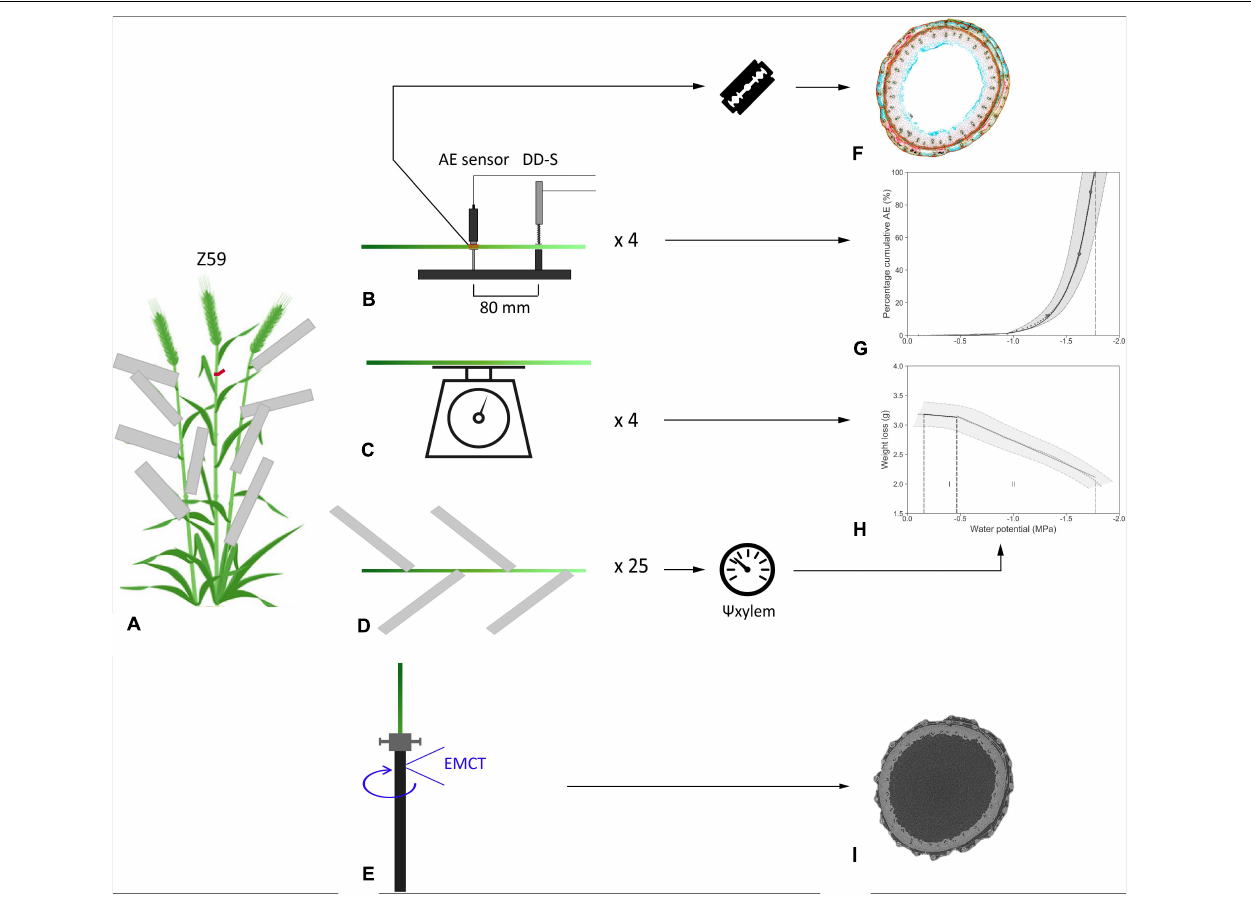
FIGURE 1 | Illustration of the workflow for (A) sampling and (B–D) measurements during bench dehydration, processing the data into (G) vulnerability and (H) desorption curves, (F) preparation of stem cross-sections, and (E,I) experimental setup of T. aestivum cultivar Excalibur in the